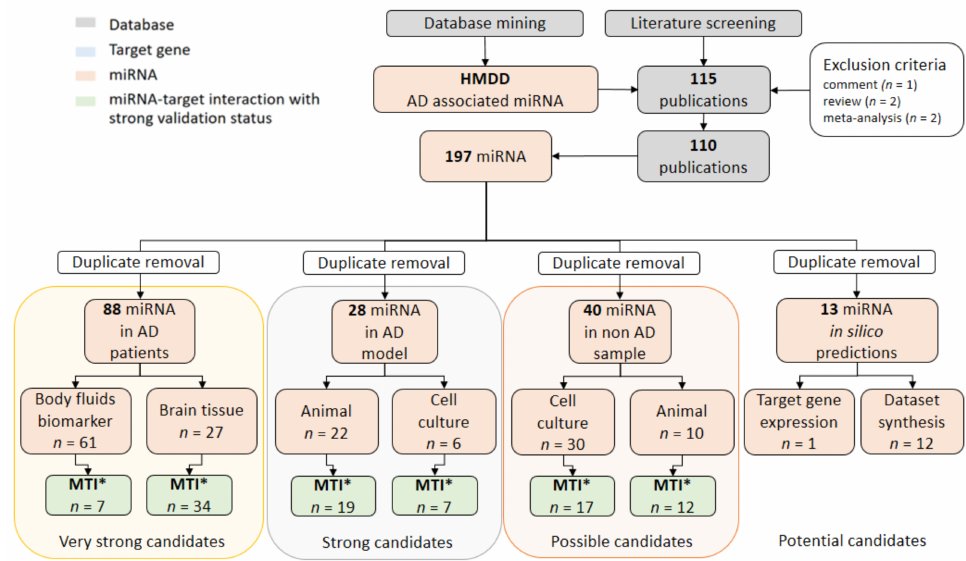
Figure 2. Data extraction of AD-associated miRNAs from HMDD and manual literature curation of experimentally validated MTI. Database mining resulted in a list of publications, investigating the role of derived miRNAs that were manually screened for their abundance in different sample types. miRNAs were curated as very strong candidates (association observed in a sample of AD patients), strong candidates (association observed in AD cell or animal models), and possible candidates (association observed in non-AD cell or animal models). In silico predictions were also highlighted as potential AD-associated candidates, suggesting further research. AD = Alzheimer‘s disease; HMDD = Human microRNA Disease Database; MTI* = miRNA-target interaction, extraction from previously published literature.